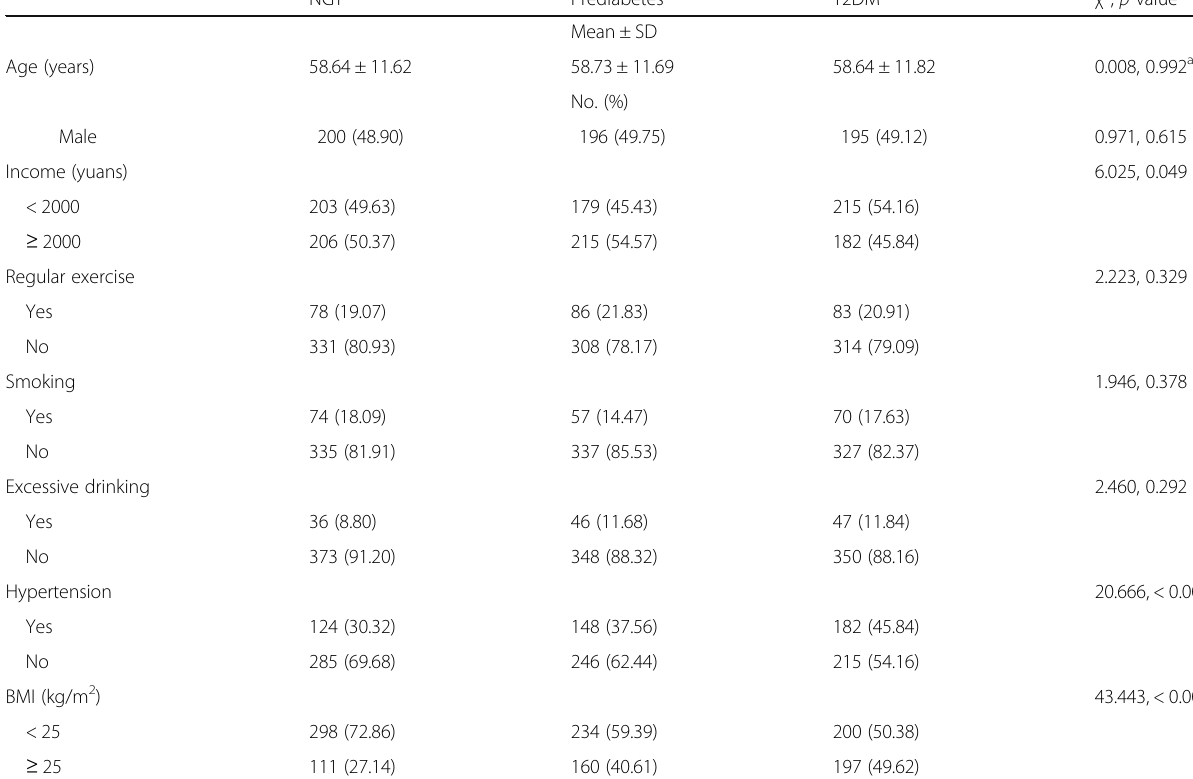
Table 1 General characteristics of subjects with normal glucose tolerance (NGT), prediabetes and type 2 diabetes (T2DM) NGT Prediabetes T2DM χ 2 , p